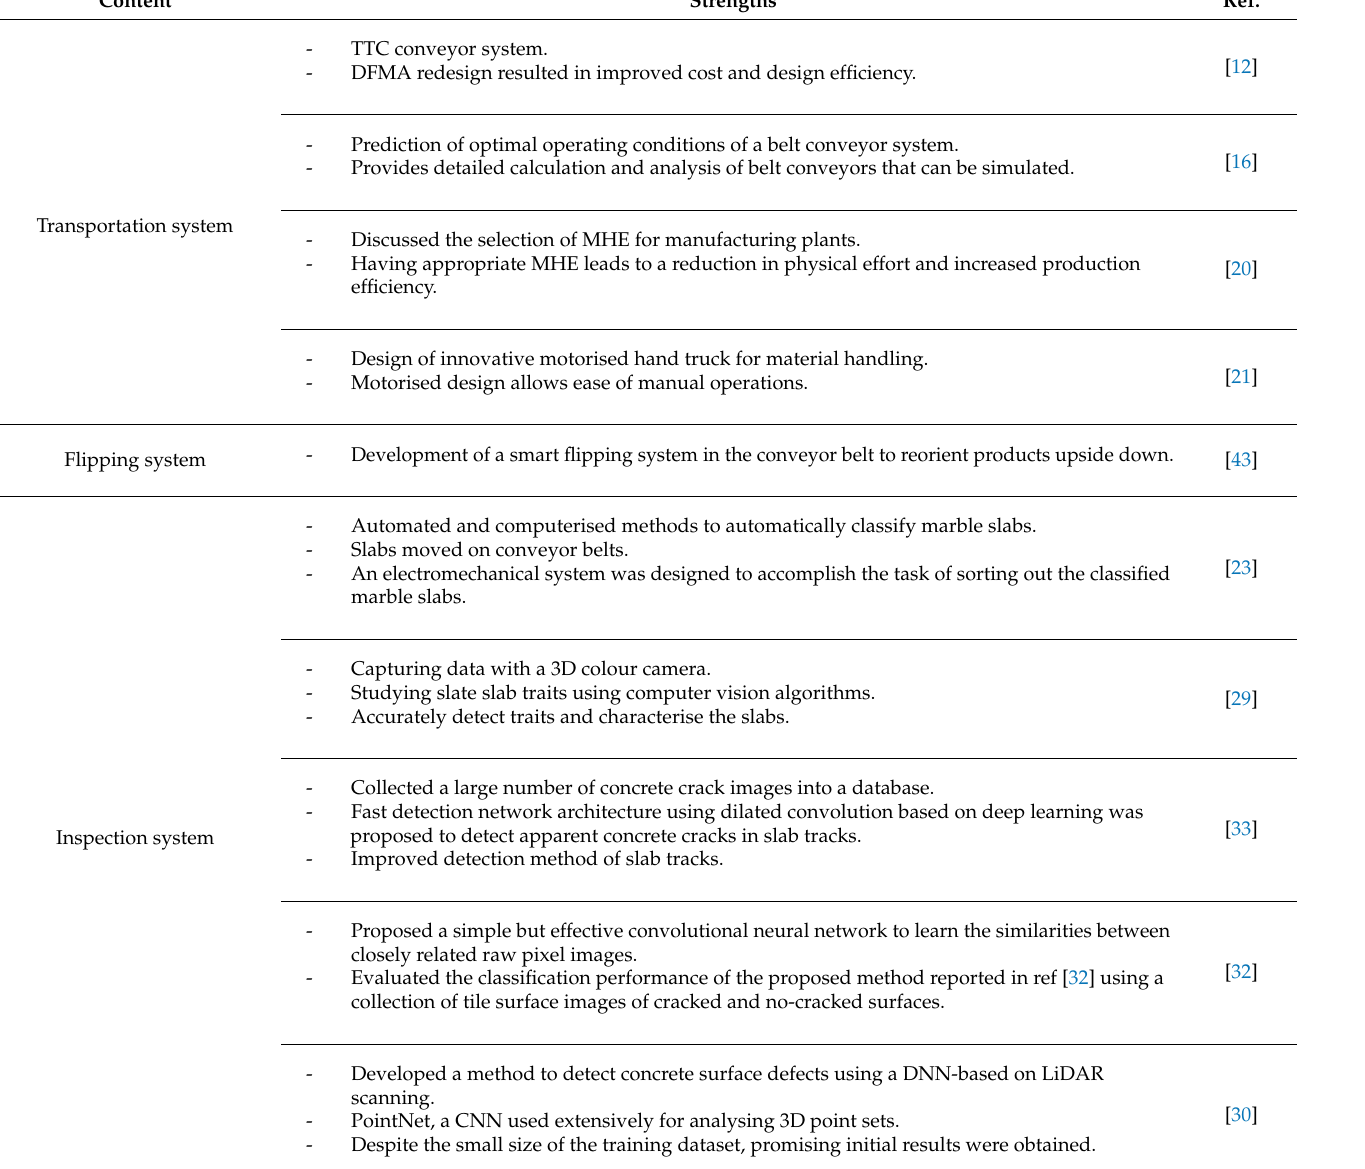
Table 5. Summary of key findings of recent studies on manufacturing systems. Strengths